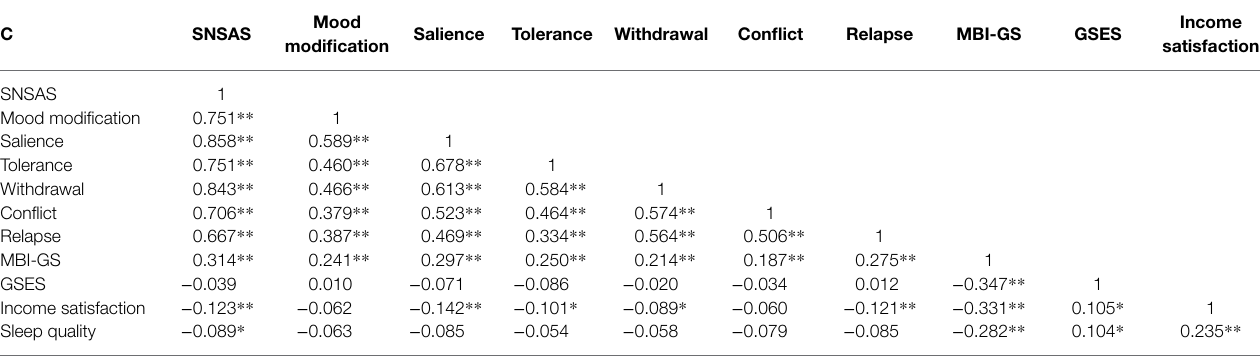
TABLE 6 | Pearson correlation analysis of self-efficacy, income satisfaction, sleep quality, and SNSAS scores.